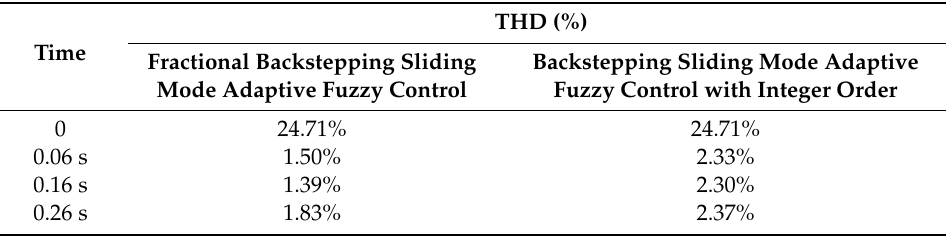
Table 2. Total harmonic distortion (THD) in proposed controller and normal